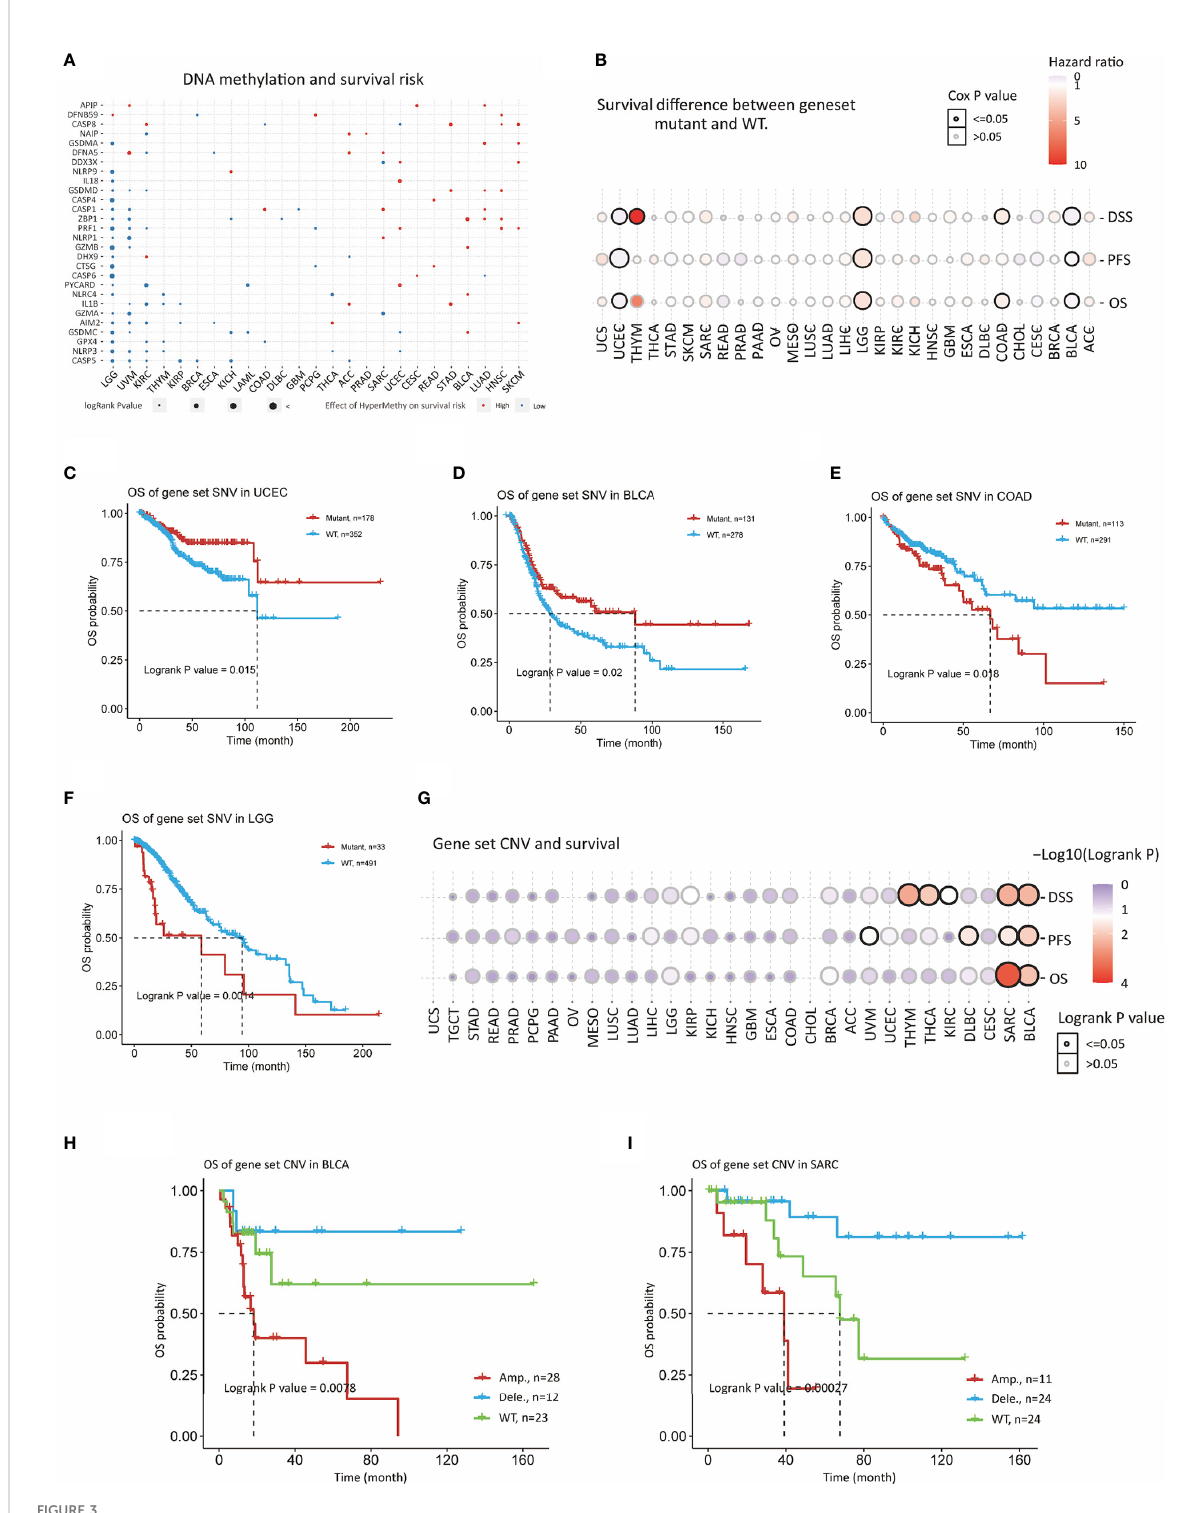
FIGURE 3 Prognostic signi fi cance of genomic aberrations in PRGs. (A) Survival risk of methylation of PRGs. Red and blue indicate risky and protective effect of PRGs methylation. (B) Bubble plot depicts survival difference between SNV mutant and WT groups in cancers. (C) Kaplan-Meier curves shows survival difference between SNV mutant and WT groups in UCEC, (D) BLCA, (E) COAD, and (F) LGG (G) Bubble plot depicts survival difference between CNV Amp, Del, and WT in cancers. (H) Kaplan-Meier curves survival difference between CNV Amp, Del, and WT in BLCA and (I)